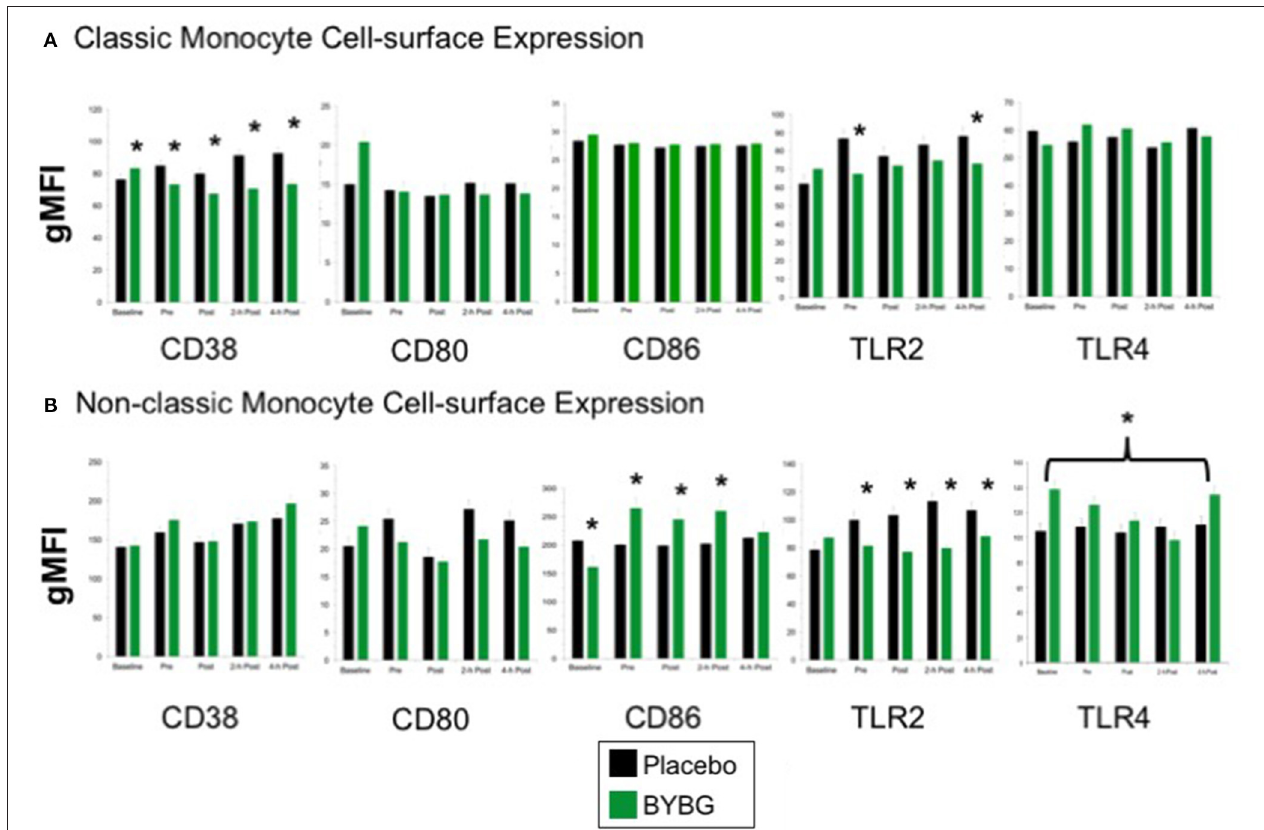
FIGURE 4 | Effect of BYBG on peripheral blood monocyte phenotype. Monocyte cell-surface receptor expression on monocyte subsets was determined using peripheral blood mononuclear cells (PBMC) isolated from human whole blood samples. The expression of CD38, CD80, CD86, TLR2, TLR4 was analyzed by gMFI for each receptor on the whole population of classic CD14 + /CD16 − (A) and non-classic CD14 + /CD16 + (B) . Values represent the mean ± SEM. * indicates BYBG significantly different than placebo ( p <